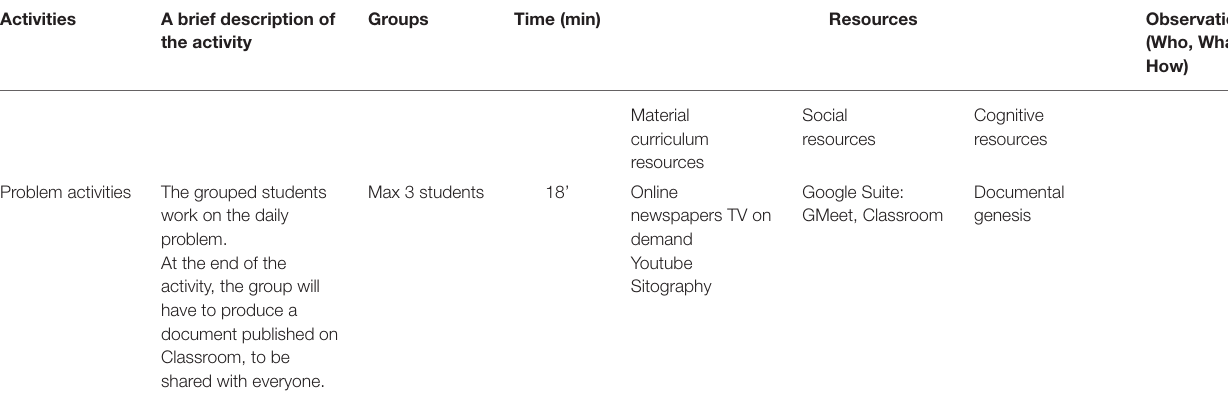
TABLE 2 | The lesson plan schedule for each activity in the second Lesson Study cycle.